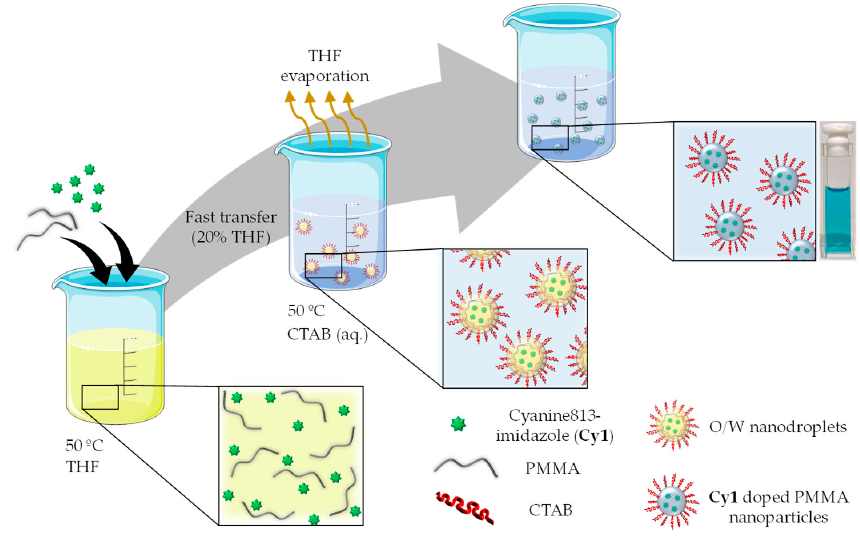
Figure 5. Synthesis of Cy1 doped PMMA nanoparticles.